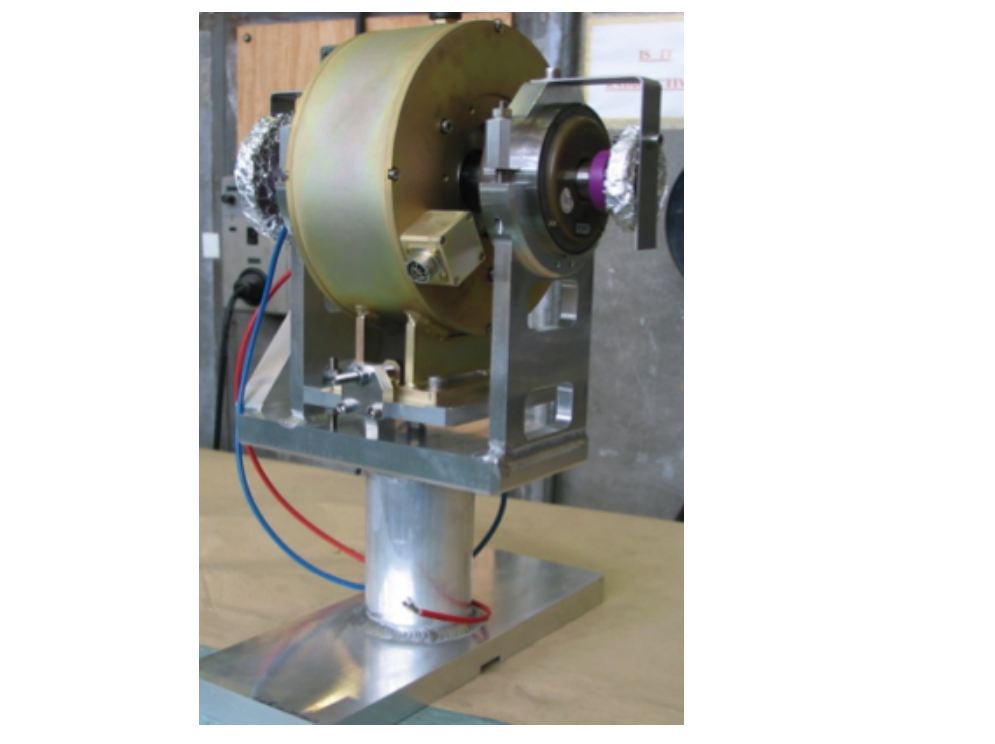
Figure 12. A Beam Current Transformed that can be adapted to measure the muon flux in nuSTORM and, in general, in a Neutrino Factory. Reproduced under CC-BY-SA license with permission from